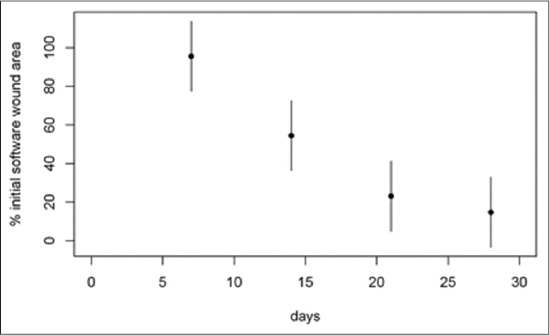
Mean percentage of software wound area respect to T0 during the 1st month of treatment. The mean percentage of wound area at day 7 was 95.5% (95% confidence interval [CI]: 77.33-113.8), at day 14 was 54.4% (95% CI: 36.22-72.6), at day 21 was 23.10% (95% CI: 4.89-41.3) and at day 28 was 14.79% (95% CI: −3.42-33) of the original size.